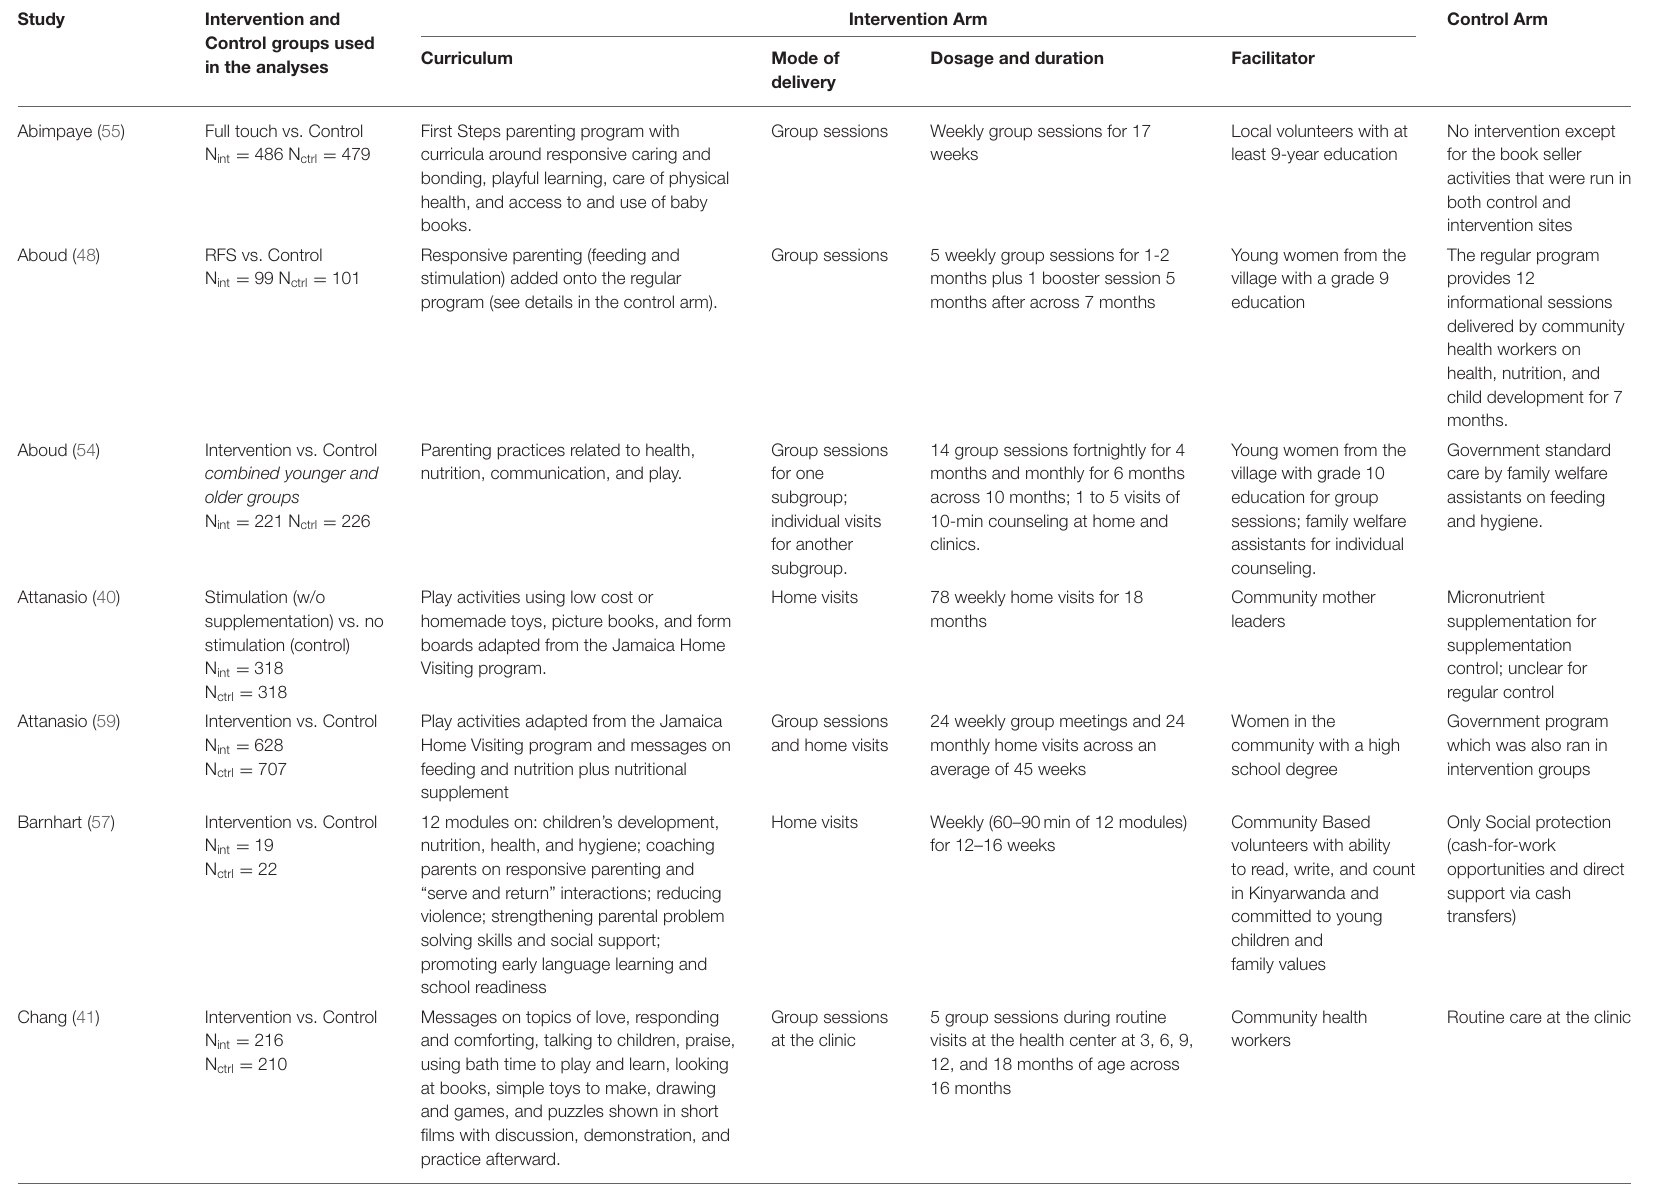
TABLE 3 | Intervention and implementation